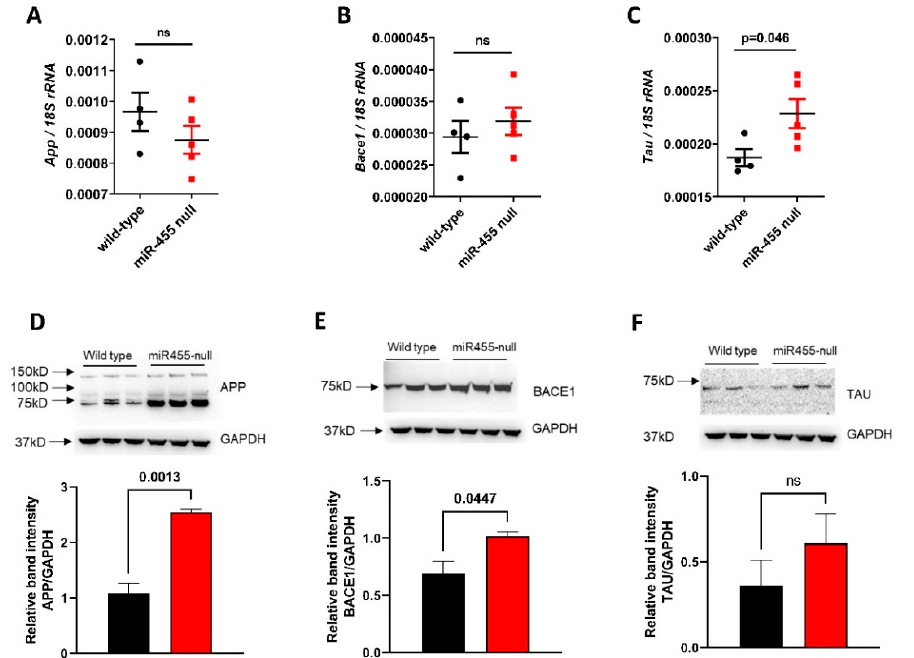
Figure 4. Expression of App , Bace1 and Tau in the mouse hippocampus. RNA and proteins were extracted from the hippocampus of wild-type vs. miR-455 null mice at 14 months of age. Levels of App , Bace1 and Tau were measured by qRT-PCR ( A – C ) and Western blot and densitometric analyses ( D – F ). Results are presented as mean ± SEM, n = 4 wild type and n = 5 miR-455 null for RNA levels and n = 3 for both wild type and miR-455 null for protein levels.